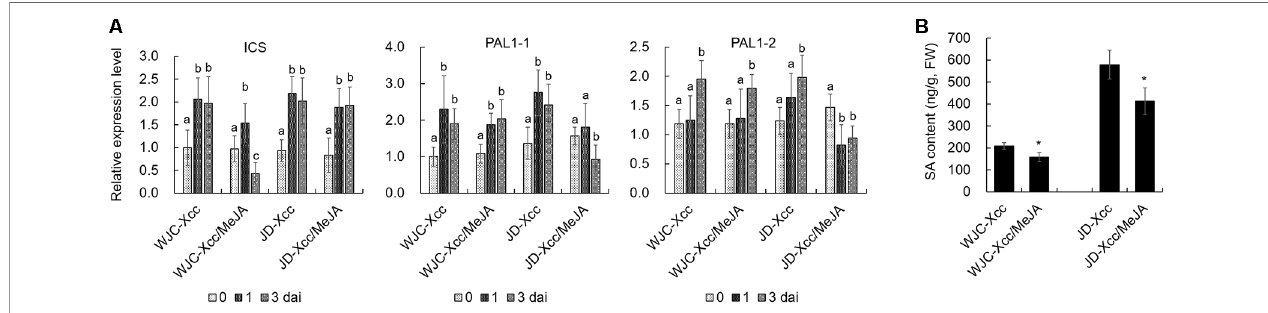
FIGURE 6 | Effects of exogenous MeJA on SA synthesis in Wanjincheng orange and Jindan leaves after infection with Xcc. (A) Effects of MeJA on the expression of SA biosynthetic genes in Wanjincheng orange and Jindan leaves after infection with Xcc. Error bars represent the SDs of three biological replicates. Different letters above bars represent signi fi cant differences from the 0 dai based on Duncan ’ s multiple range test ( P < 0.05). (B) Effects of MeJA on the SA contents in Wanjincheng orange and Jindan leaves after infection with Xcc. Error bars indicate the standard deviations of three biological repeats. Statistical signi fi cance related to the control was determined by two-tailed Student ’ s t -test (*, P < 0.05). WJC, Wanjincheng orange; JD, Jindan; Xcc, Xanthomonas citri ssp. citri ; SA, salicylic acid; MeJA, methyl jasmonate; ICS, isochorismate synthase; PAL, phenylalanine ammonia lyase.